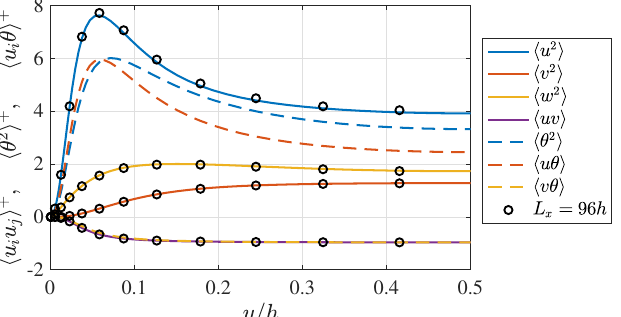
Figure 1. Profiles of mean streamwise velocity U and the mean temperature Θ in ( a ) outer and ( b ) inner scaling. In panel ( b ), the grey chained lines indicate U + = y + and U + = 2.44ln y + + 5.1 for the mean velocity profile and Θ + = Pry + for the mean temperature profile, and the black dashed line presents the profile of mean velocity U + obtained with an extremely large computational domain ( L x , L z ) = ( 96.0 h , 12.8 h ) in Ref. [4].